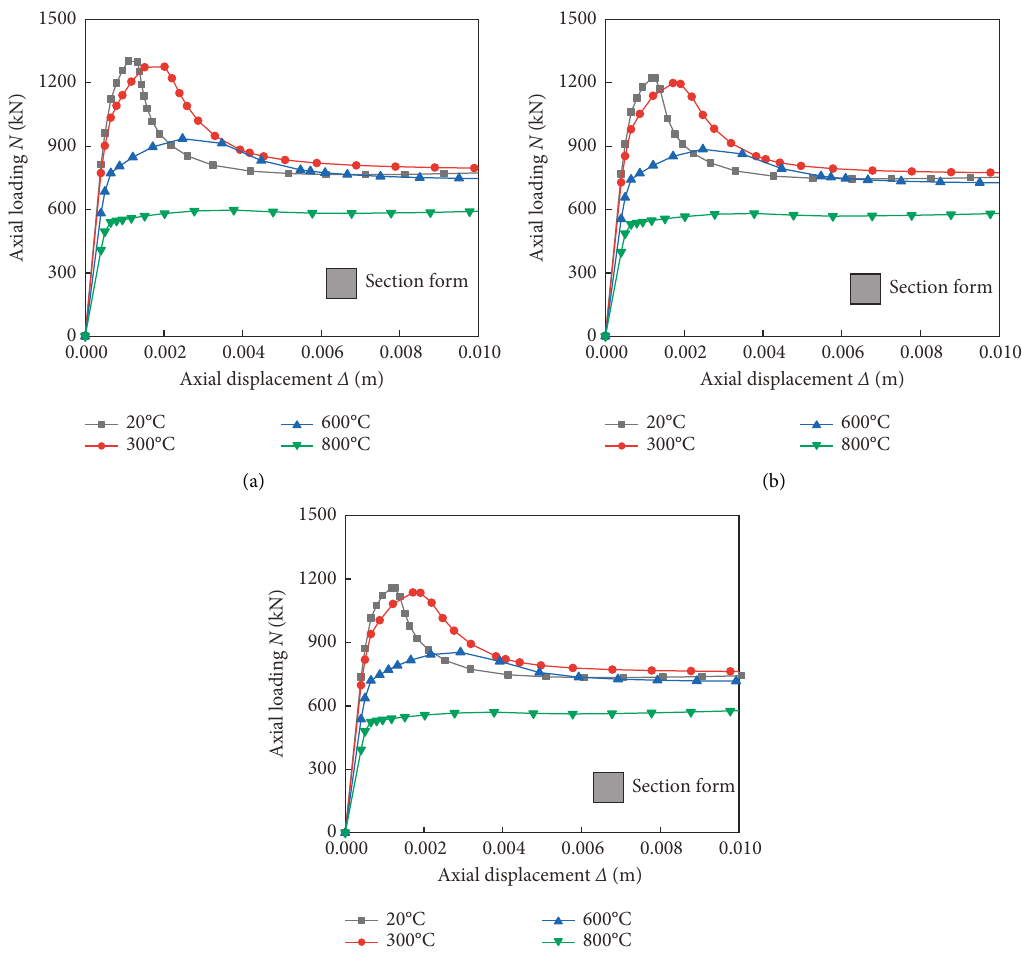
Figure 6: Load-deformation relationship curve. (a) r � 0%. (b) r � 50%. (c) r �